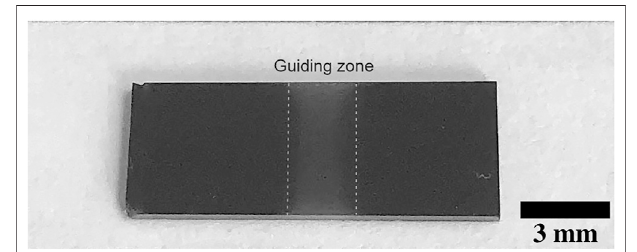
FIGURE1| Planarwaveguideonthesurfaceofanc-YSZceramicbefore annealing.